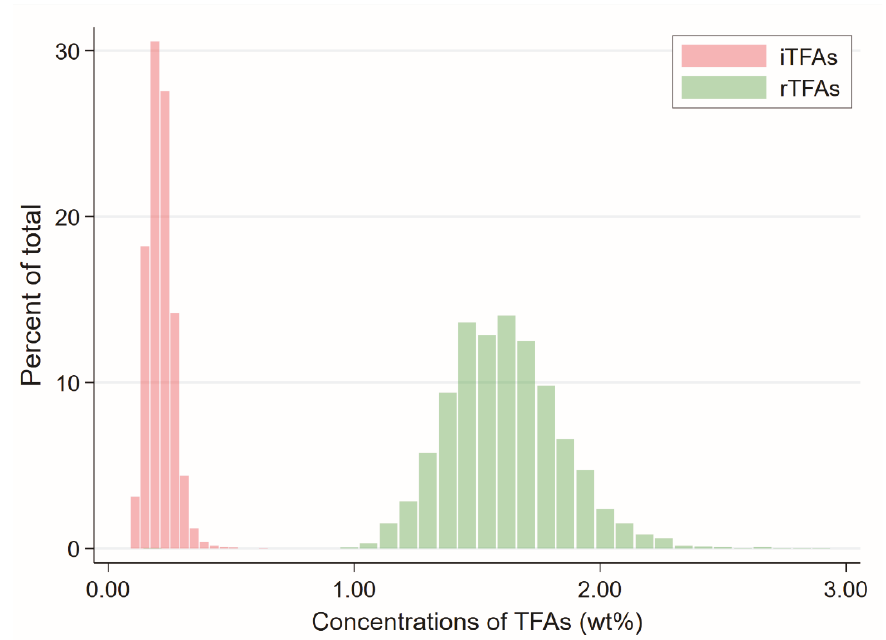
Figure 2. Distribution of industrial and ruminant trans fatty acids measured in weight percentage (wt%) of total plasma phospholipid fatty acids.